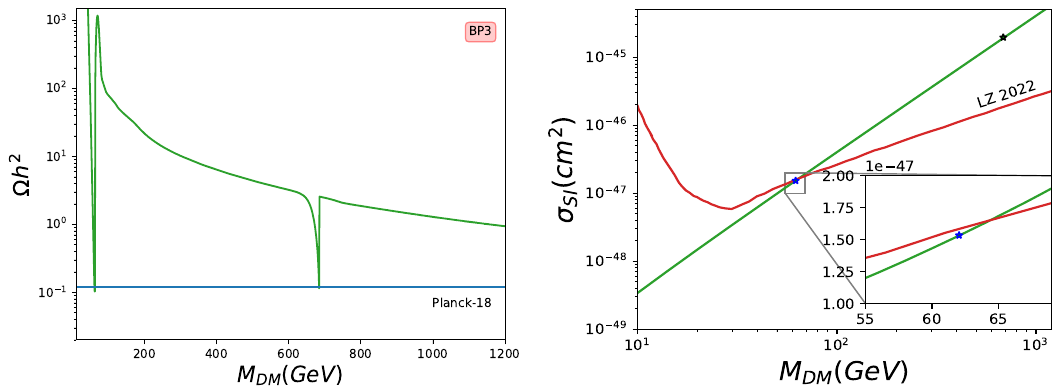
Figure 6 . Left panel: WIMP DM relic as a function of its mass for BP3, while considering singlet- SM Higgs mixing to be sin θ hS = 0 . 23 . Right panel: spin-independent DM-nucleon cross-section as a function of DM mass for the same benchmark choices of parameters considered in left panel.